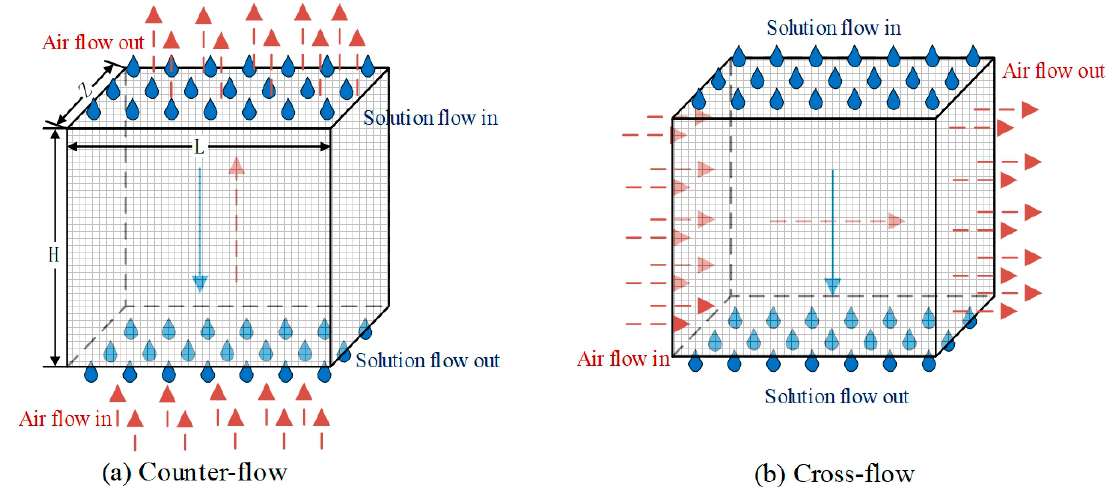
Figure 1. Schematic diagram of fluid flow direction in packing material. ( a ): Counter-flow ( b ):